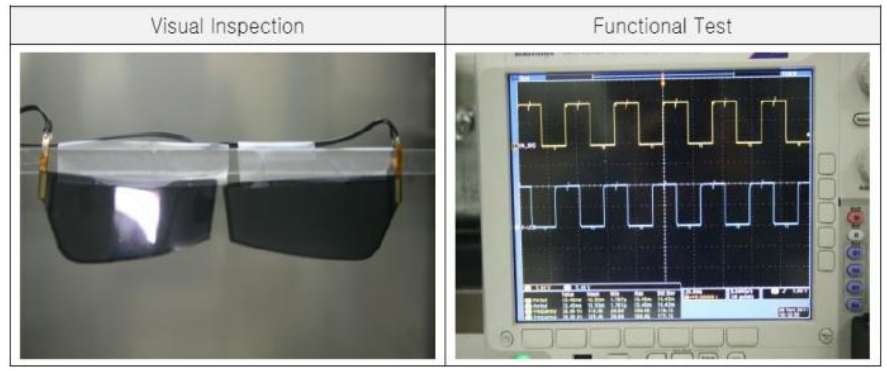
Figure 9. Results of low-high temperature operating